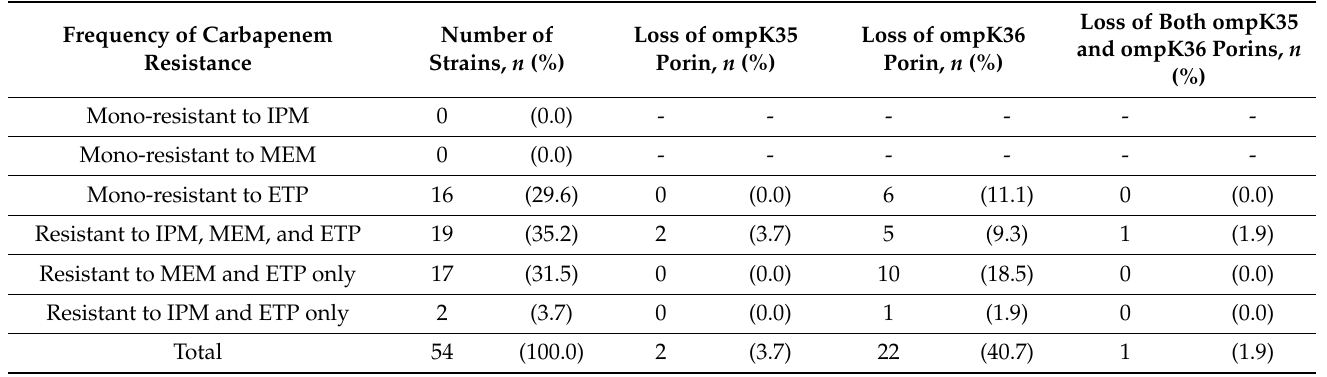
Table 2. Frequency of carbapenem resistance among 54 NC-CRKP.